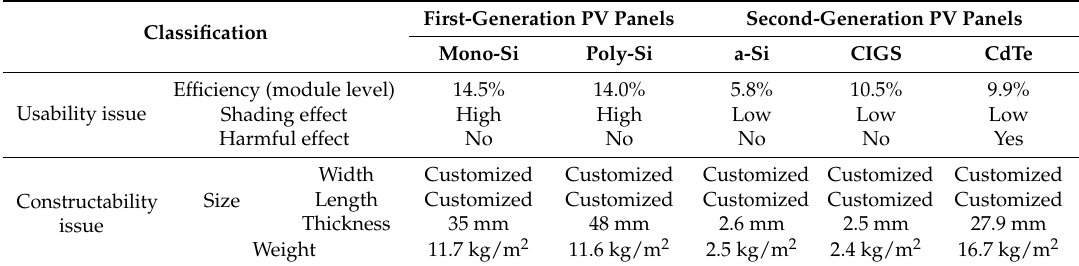
Table 2. Usability and constructability issues of the first- and second-generation PV